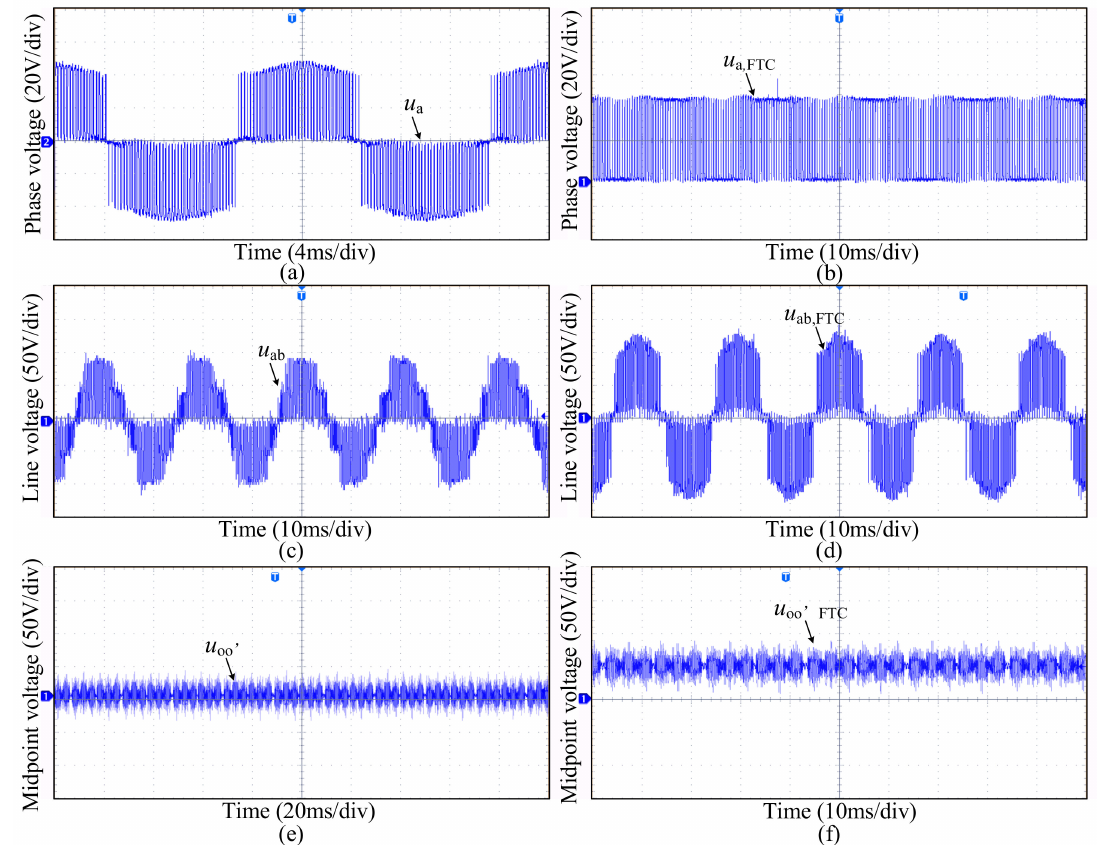
Figure 17. The waveforms of single SM fault-tolerant control. ( a ) Phase voltage in normal operation; ( b ) Phase voltage in fault operation; ( c ) Line voltage in normal operation; ( d ) Line voltage in fault operation; ( e ) Neutral point shift voltage in normal operation; ( f ) Neutral point shift voltage in fault